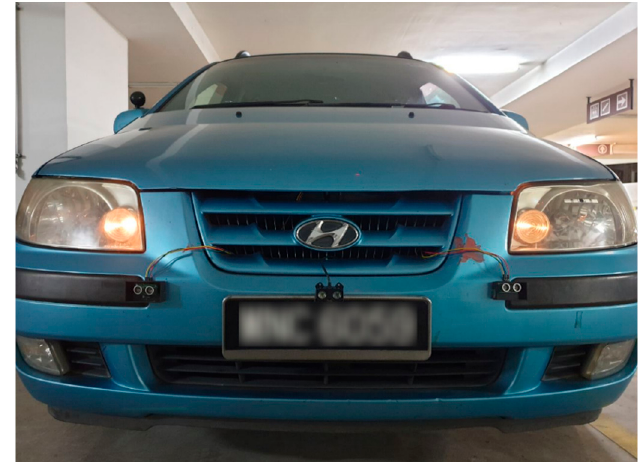
Figure 3. Installation of ultrasonic sensors and Garmin lidar on the vehicle.